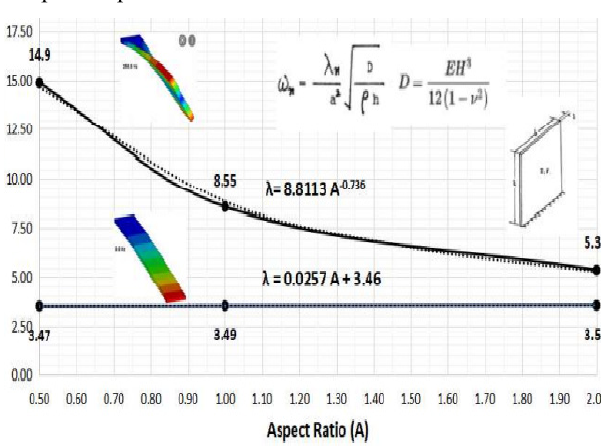
Figure 3. orthotropic correction coefficients